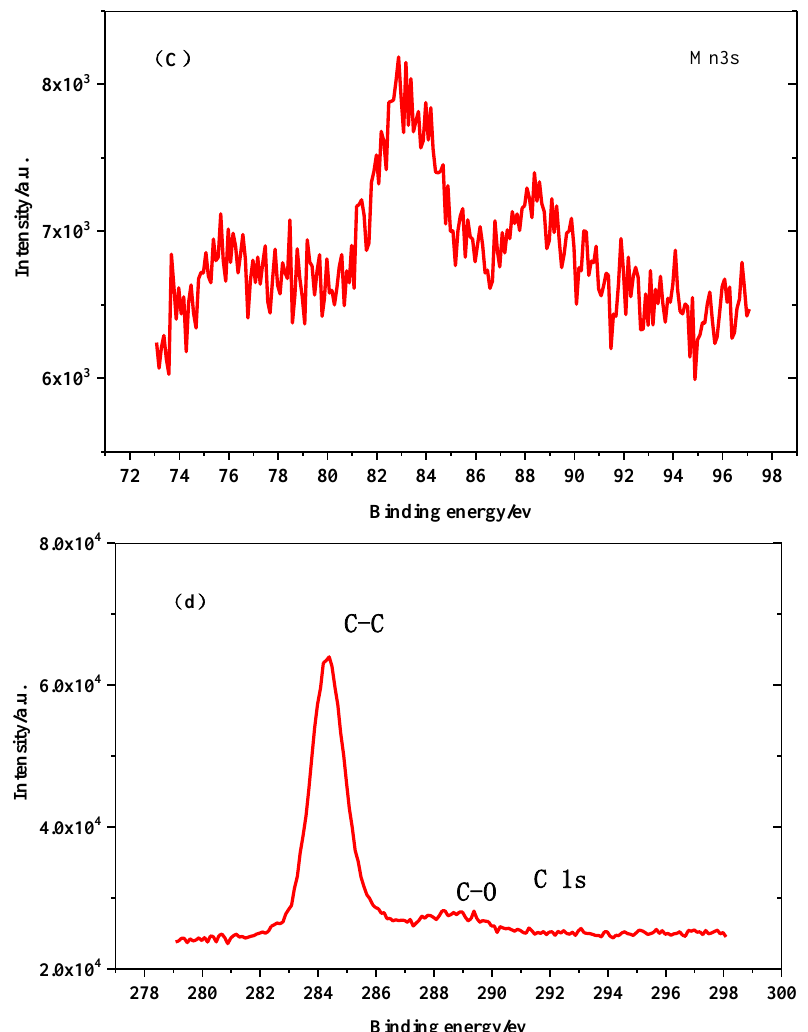
Figure 6. The XPS spectra of Sm 0.85 Sr 0.15 MnO 3- δ : ( a ) elemental analysis, ( b ) Mn2p, ( c ) Mn3s, and ( d ) C1s.